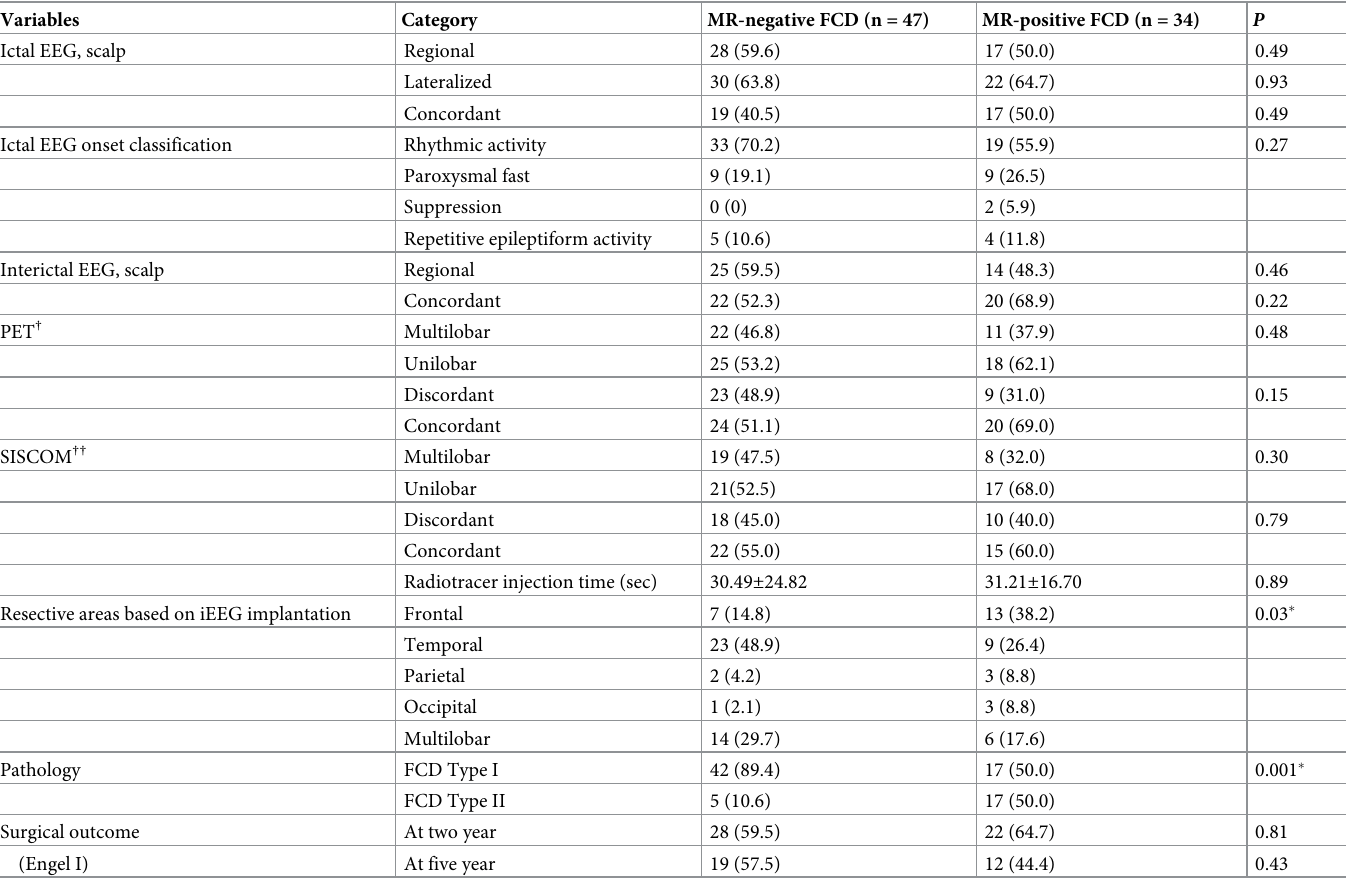
Table 2. Results of the presurgical evaluations and surgical